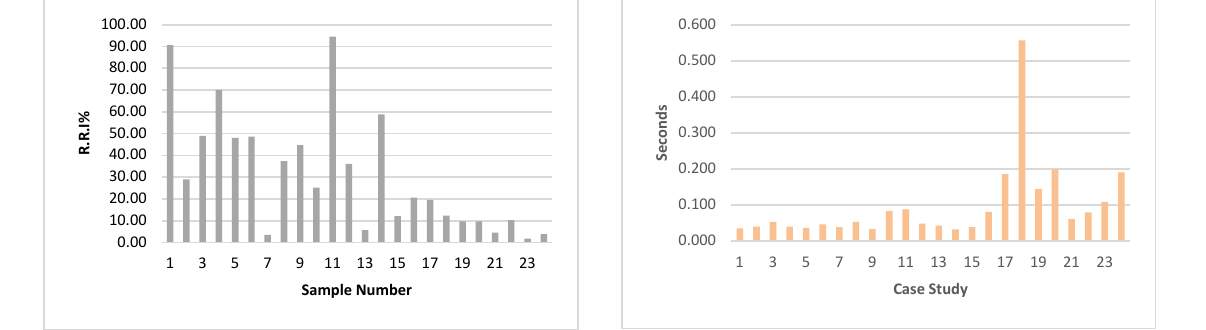
Fig. 3. The results of the R.R.I% index for the solved case Fig. 4. The results of solving time for the studied studies